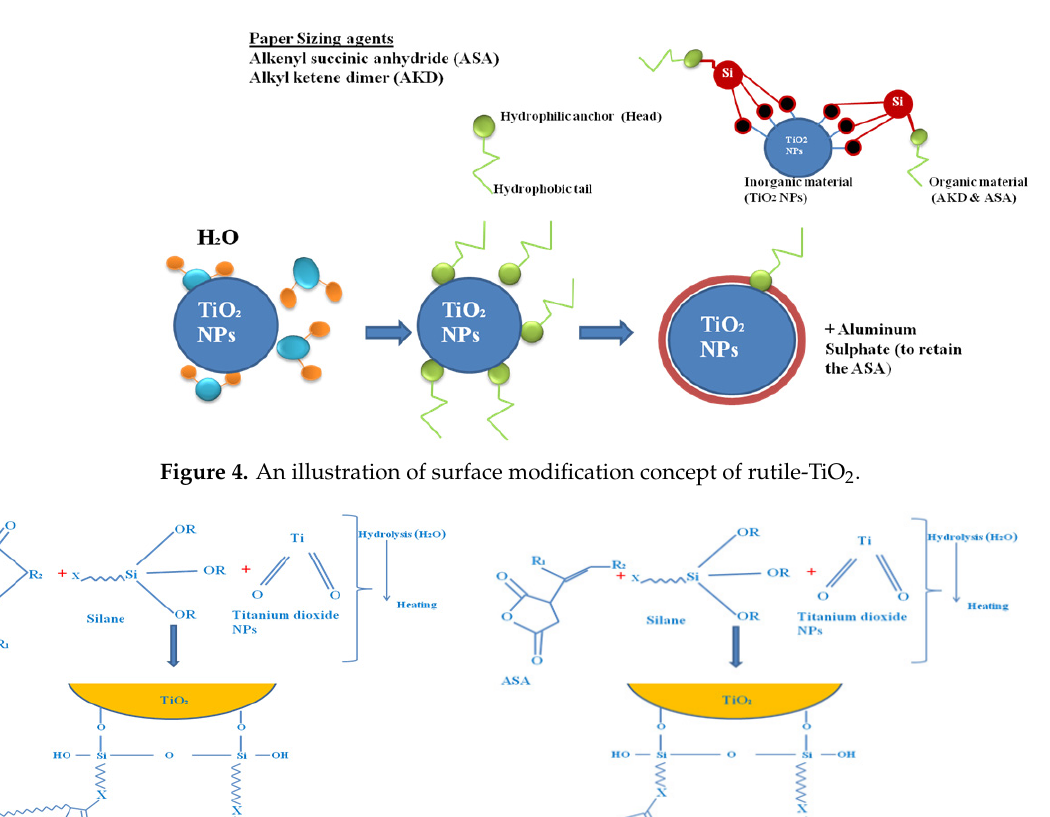
Figure 5. Reaction mechanism model: ( a ) TiO 2 NPs/AKD; ( b ) TiO 2 NPs/ASA.